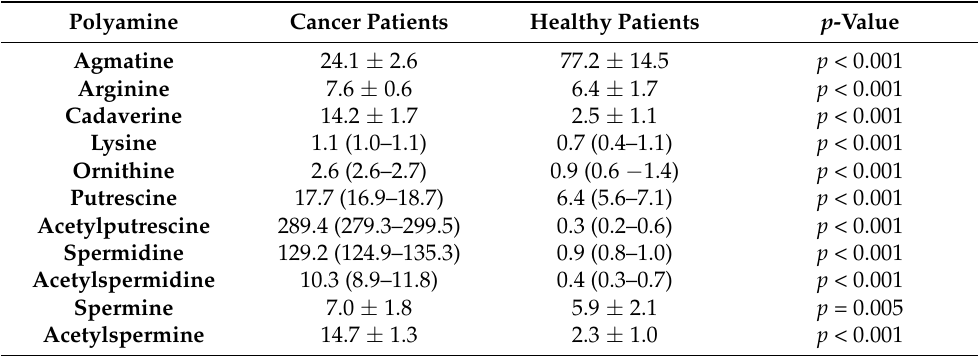
Table 3. Levels of plasma polyamines and related amino acids (arginine and lysine) in patients with colorectal carcinoma and healthy